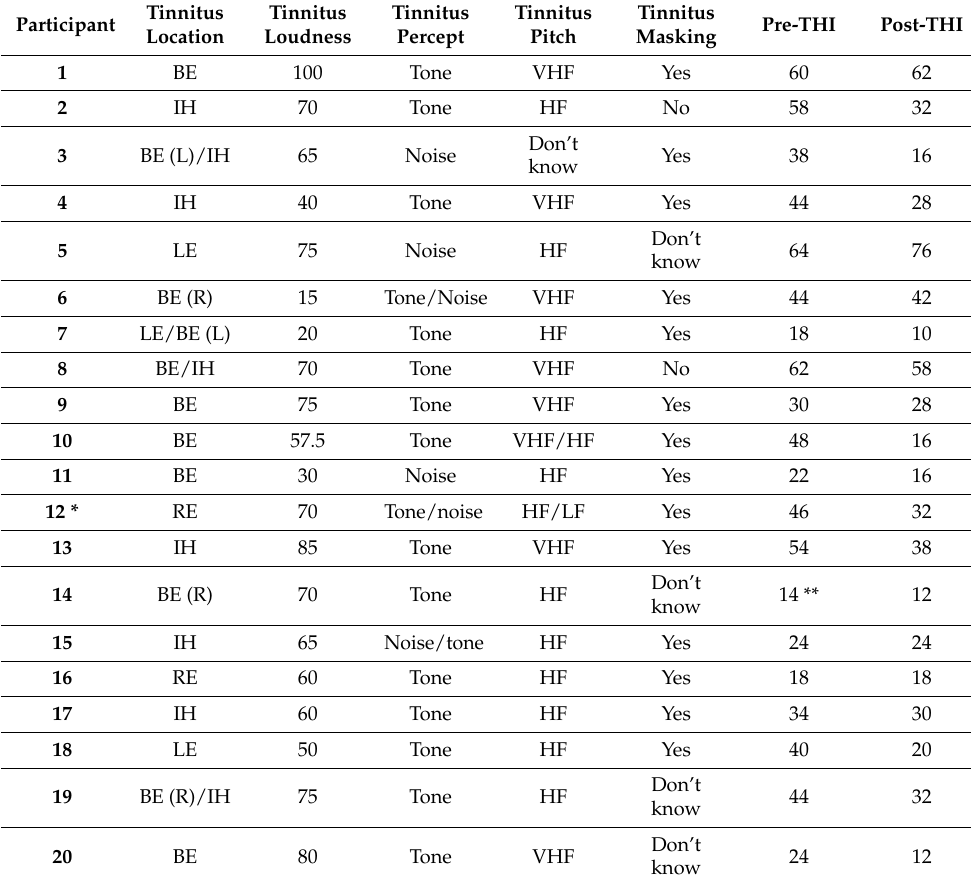
Table 1. Description of tinnitus percept based on answers from the Tinnitus Sample Case History Questionnaire. Tinnitus location: BE = Both ears equally, BE(R) = Both ears, mainly the right ear, BE(L) = Both ears, mainly the left ear, LE = Left ear, RE = Right ear, IH = Inside head. Tinnitus pitch: VHF = Very High-frequency, HF = High-frequency, MF = Medium frequency, LF = Low-frequency.